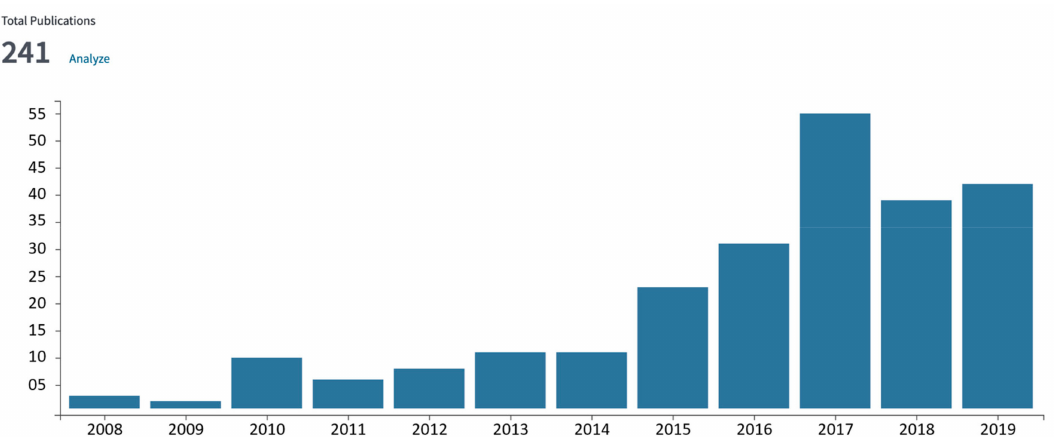
Figure 1. Publication report by the Web of Science for BIM and GIS integration (exerted from https: // apps.webofknowledge.com /